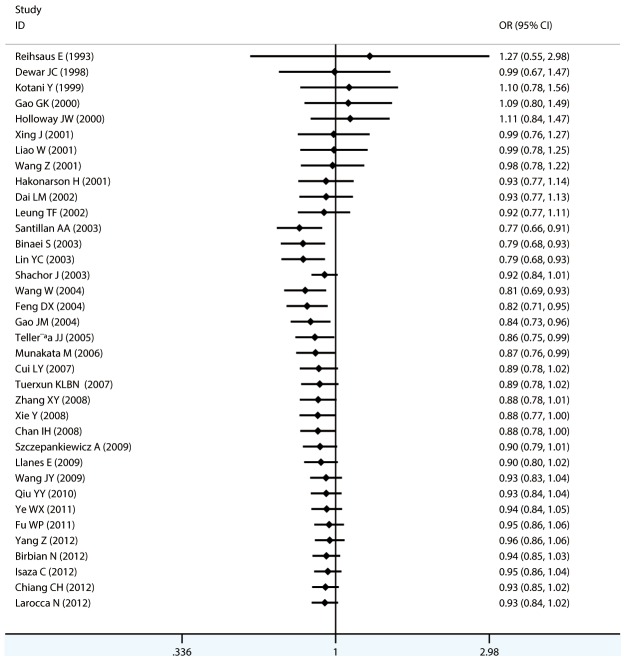
Forest plots of cumulative meta-analysis of Gln27Glu (rs1042714) in association with asthma by published year dominant model comparison.